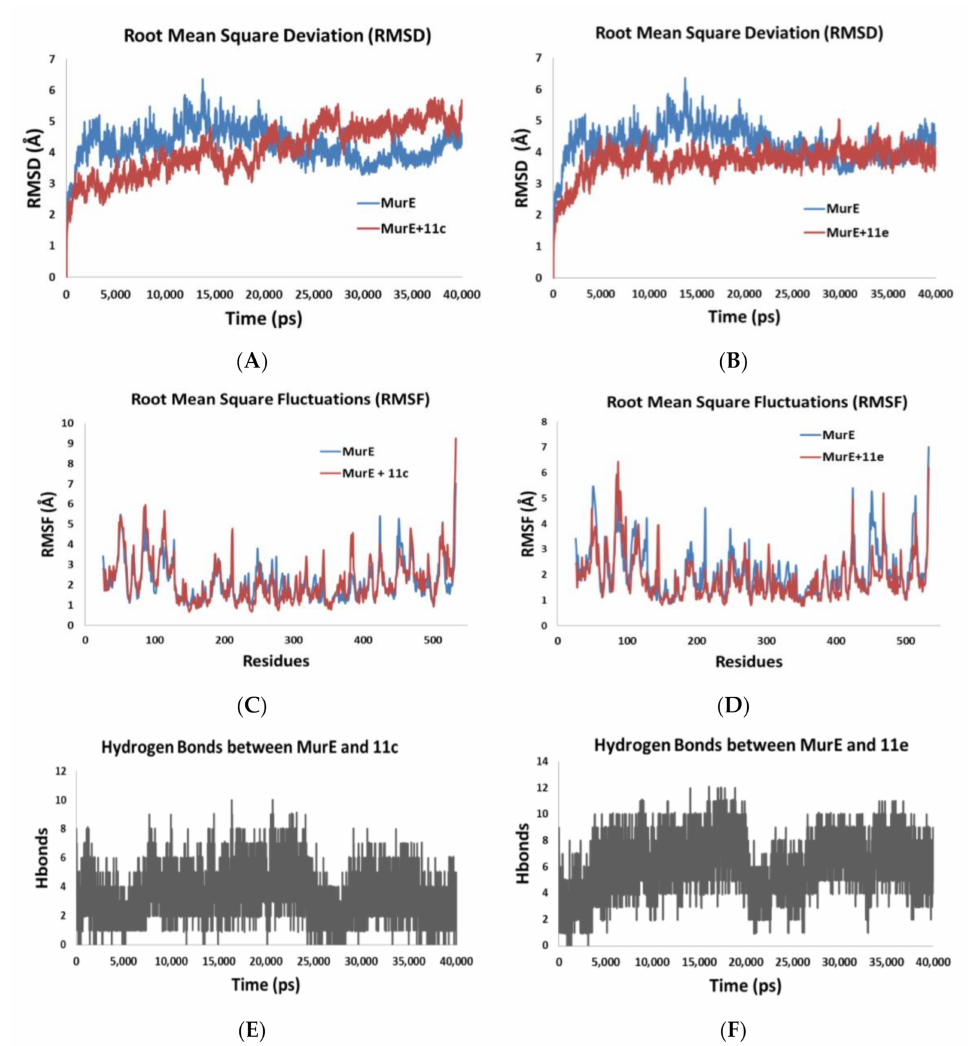
Figure 3. Molecular dynamic simulation plots of compounds 11c and 11e , respectively, with Mtb MurE: ( A ) and ( B ): RMSD plots; ( C ) and ( D ): RMSF plots; ( E ) and ( F ): hydrogen